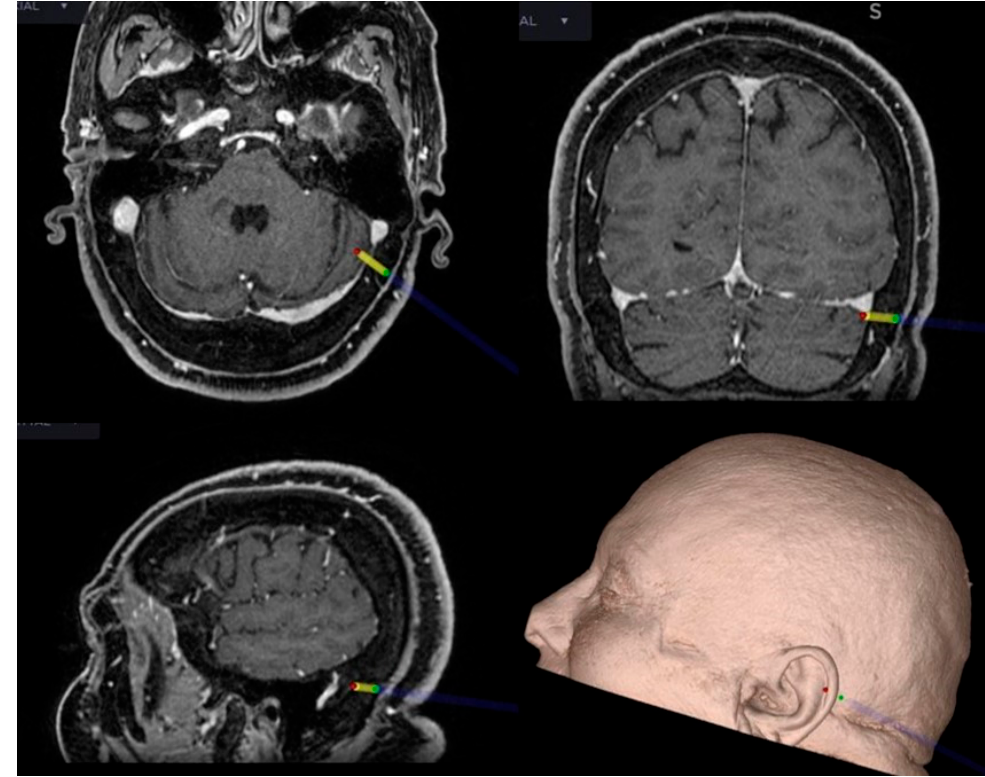
Figure 3. Intraoperative neuronavigation in CPA surgery. The key point for the craniotomy is set just behind and below the TSSJ.